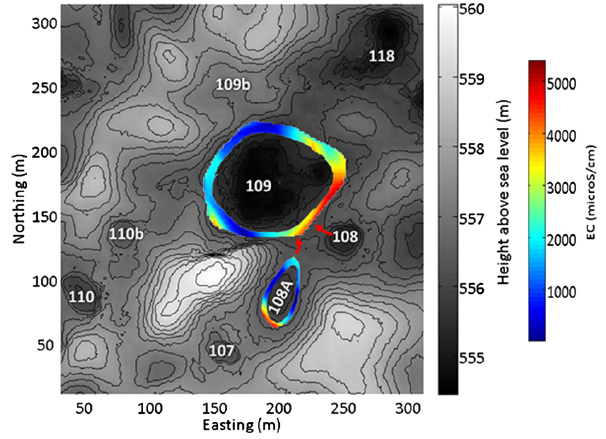
Fig. 8. Salinity around ponds 109 and 108A. Red arrows indicate the direction and location of overland flow during the observation